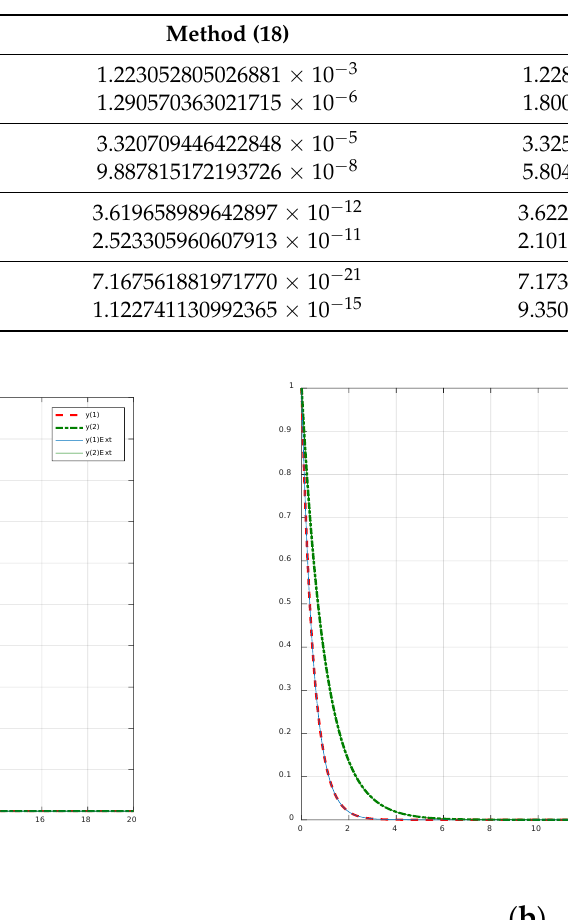
Table 2. Absolute errors in the numerical integration of Example 1.